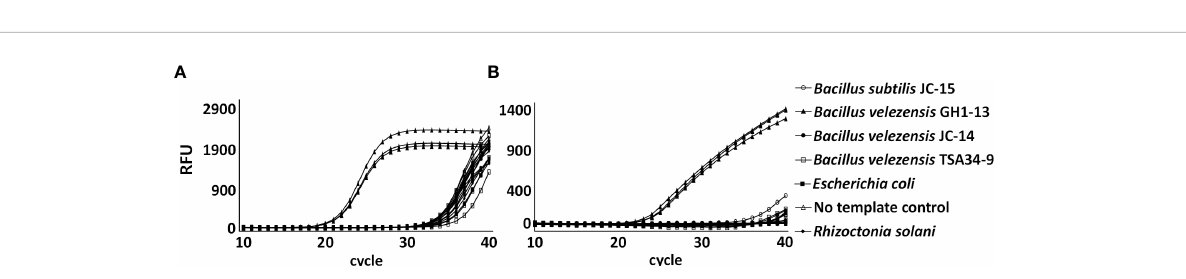
FIGURE 6 Ampli fi cation of chromosomal unique gene region of Bacillus velezensis GH1-13 from 0.1 ng initial DNA of B. velezensis GH1-13, B. velezensis JC-14, B. velezensis TSA34-9, Bacillus subtilis JC-15, Escherichia coli , Rhizoctonia solani and no template control by SYBR Green qPCR analysis using a primer pair F_uniqueC and R_uniqueC (A) and TaqMan qPCR analysis using a primer pair Ft_uniqueC and Rt_uniqueC (B) .